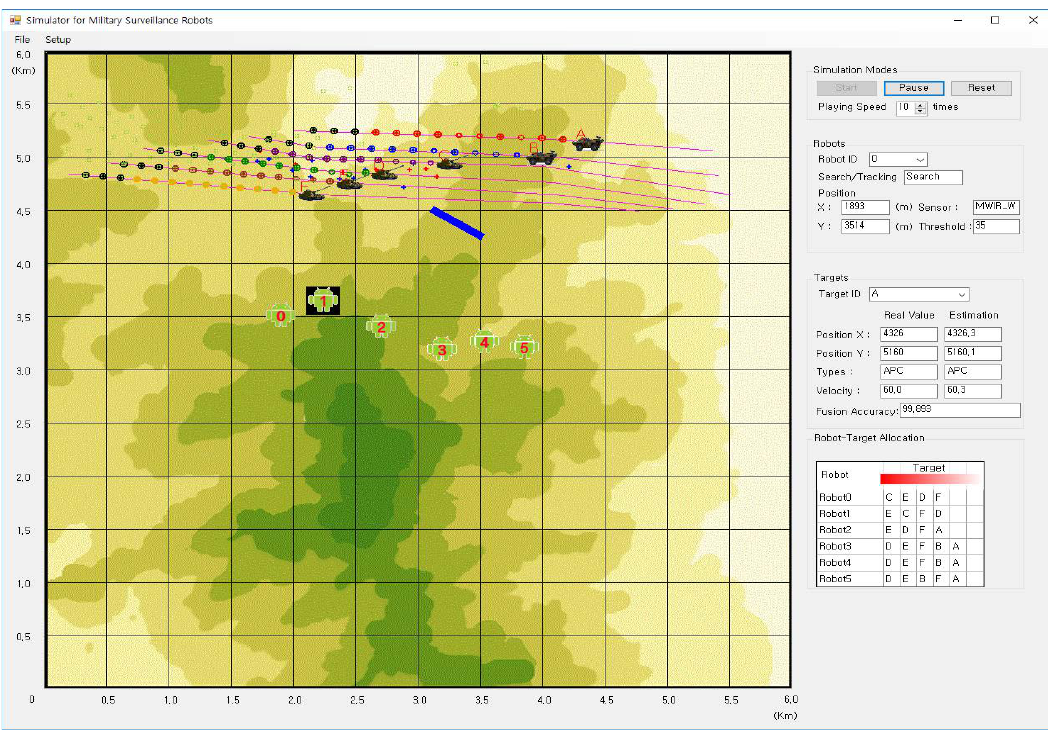
Figure 3. Intelligent simulator for data fusion and target allocation in battlefield